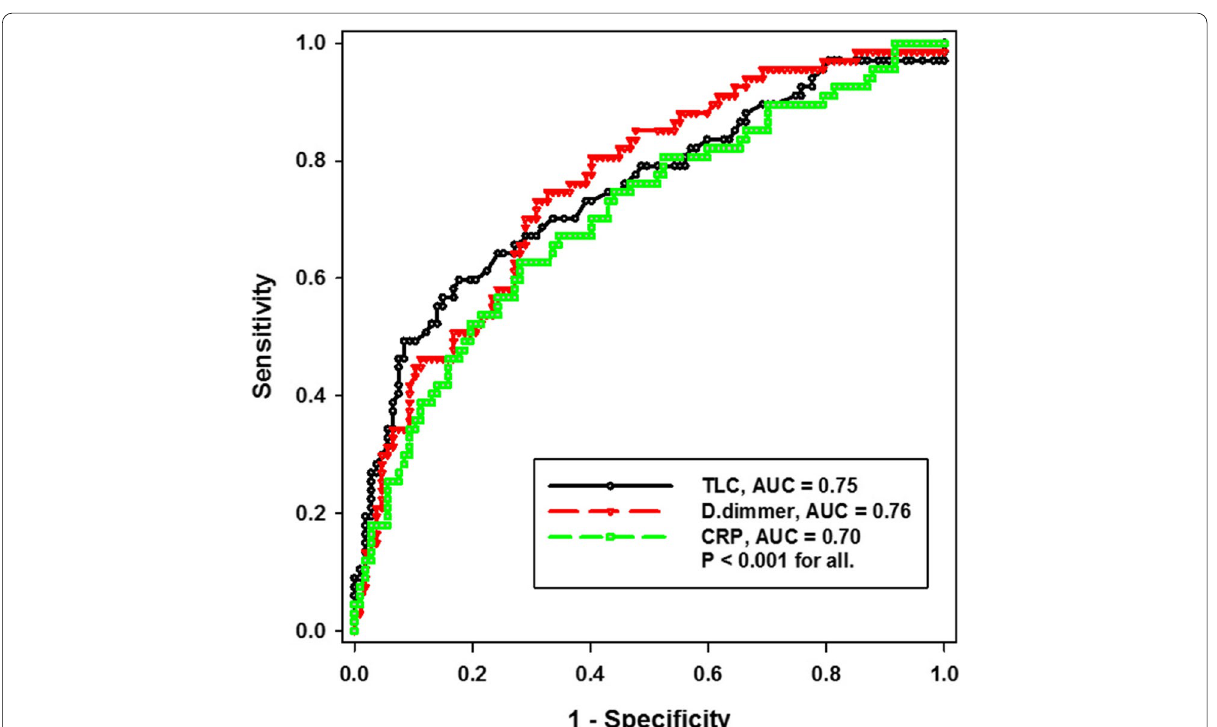
Fig. 1 Receiver operating curve for the sensitivity and specificity of TLC, d ‑dimer, and CRP in predicting the severity of COVID‑19 pneumonia. TLC, total leukocytic count; AUC, area under the curve; CRP, C‑reactive protein